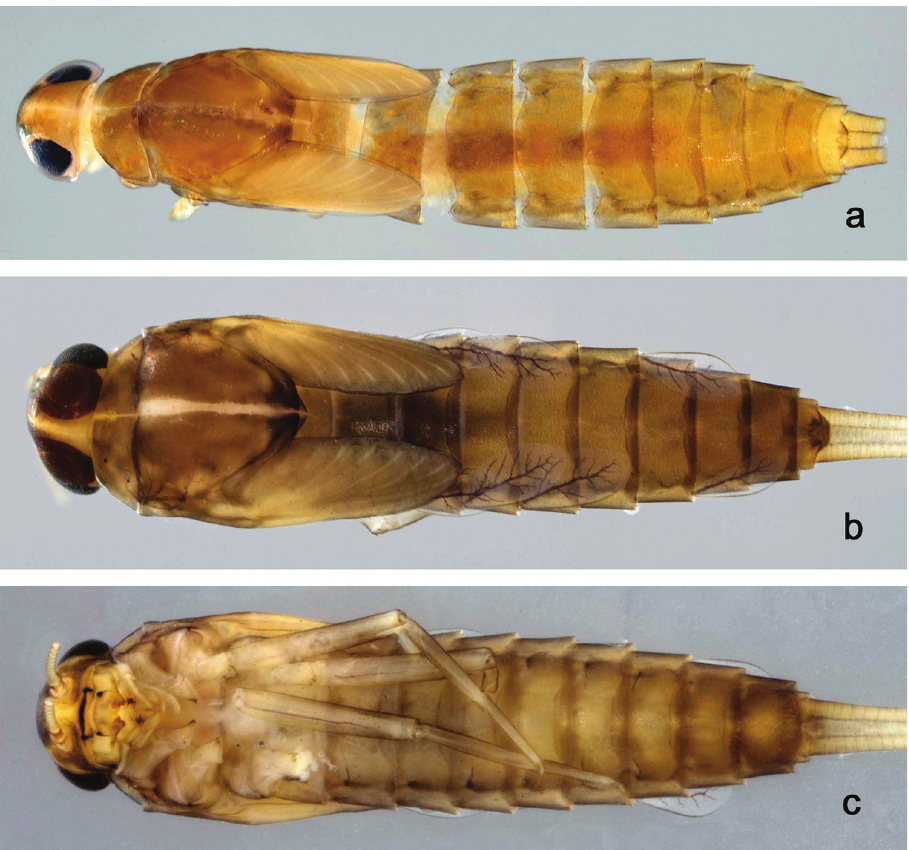
Figure 1. Habitus, larvae: a Indocloeon spathasetis sp. n., dorsal view b Indocloeon timorense sp. n., dorsal view c Indocloeon timorense sp. n., ventral